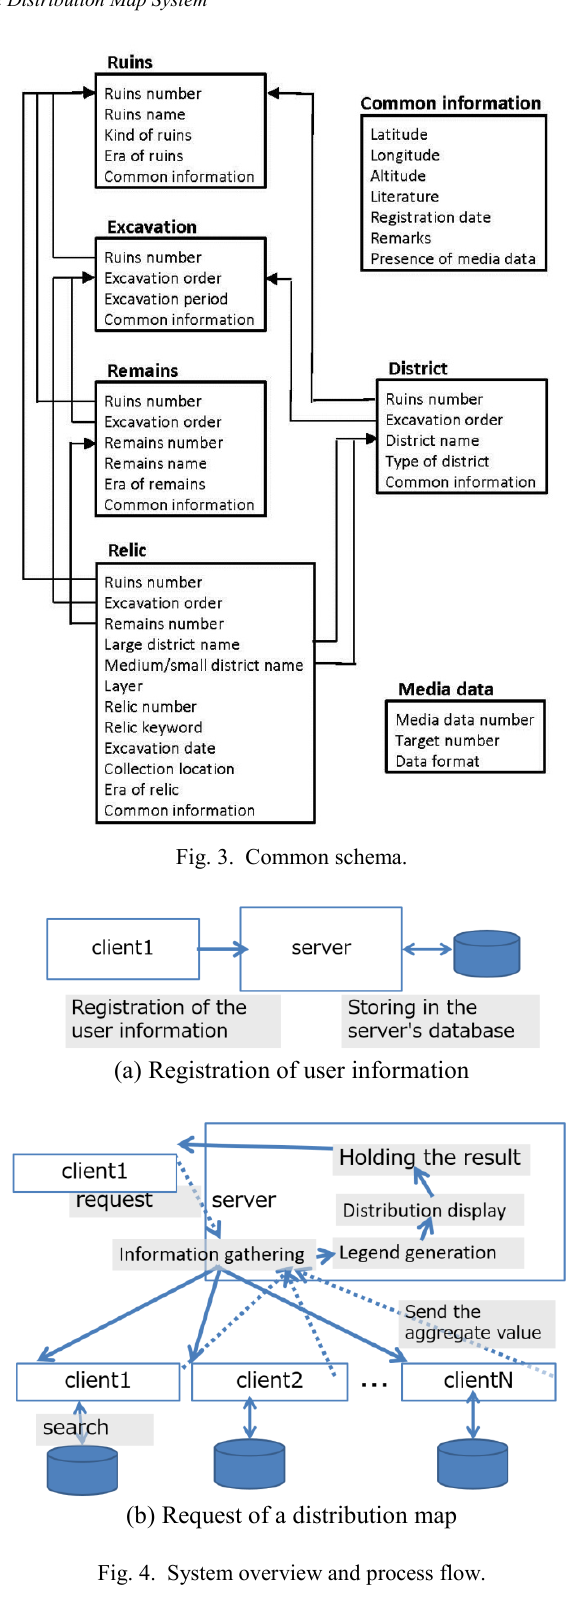
Fig. 4. System overview and process